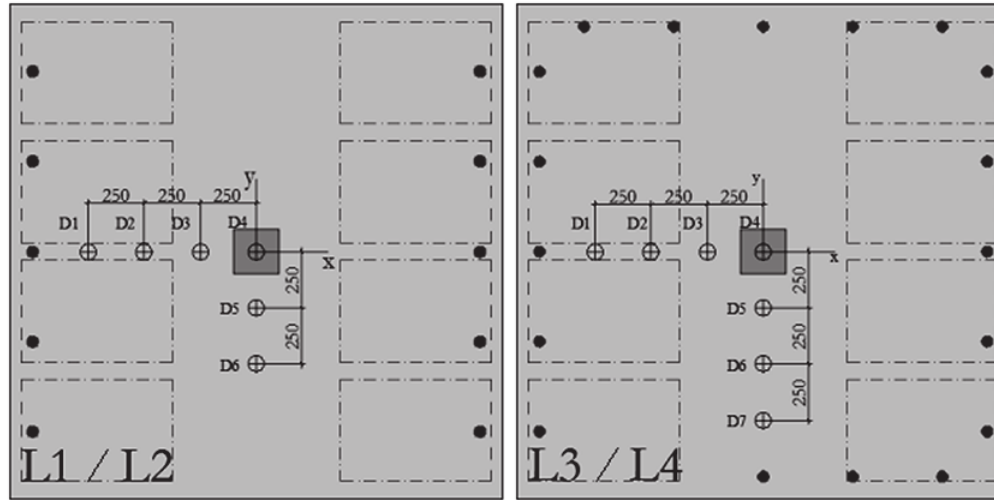
Figura 6 Posicionamento dos defletômetros digitais nas lajes